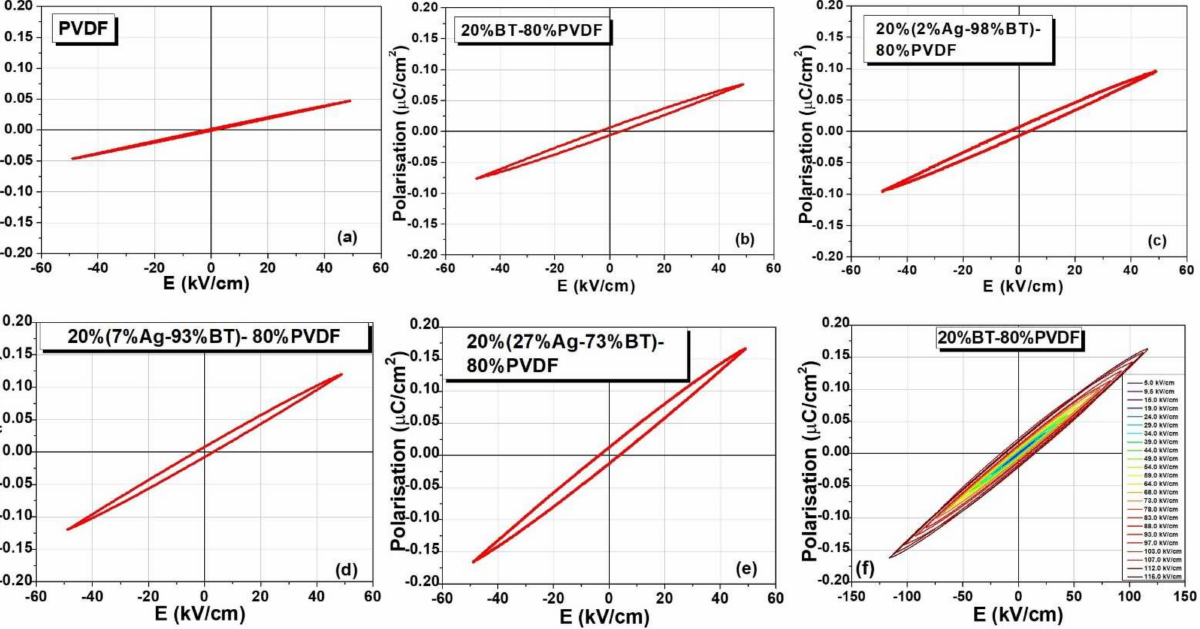
Figure 7. Comparative polarization-field loops at the same field amplitude of 50 kV/cm for the 20%( x Ag − (1 − x )BT) − 80%PVDF flexible composites: ( a ) PVDF, ( b ) x = 0, ( c ) x = 2 vol.%, ( d ) x = 7 vol.%, ( e ) x = 27 vol.%, and ( f ) P ( E ) for the maximum applied field of 116 kV/cm for the composition x =